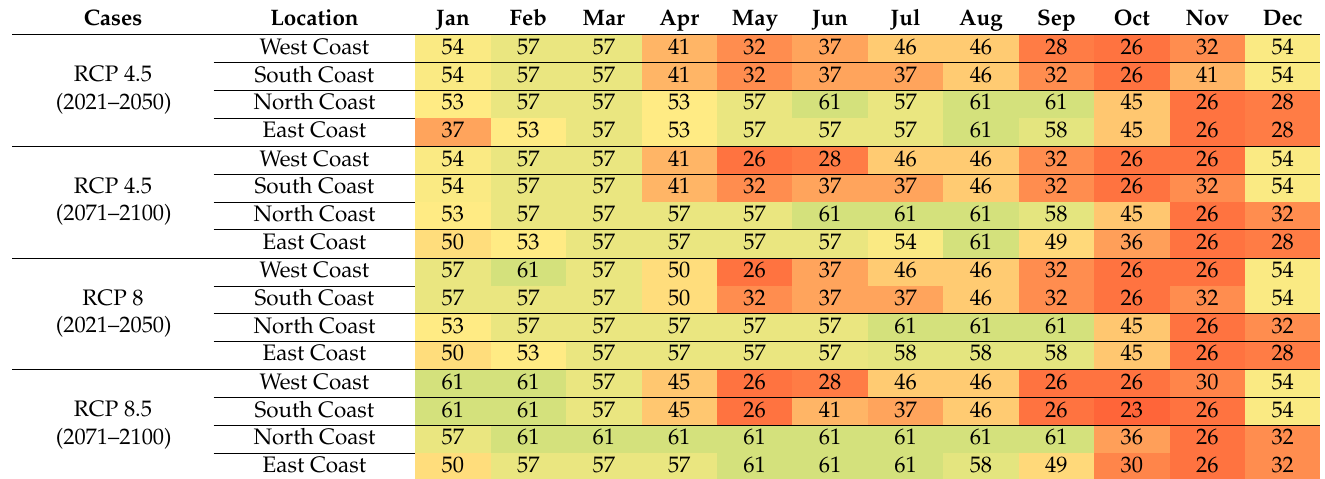
Table A3. HCI beach scores for considered cases.